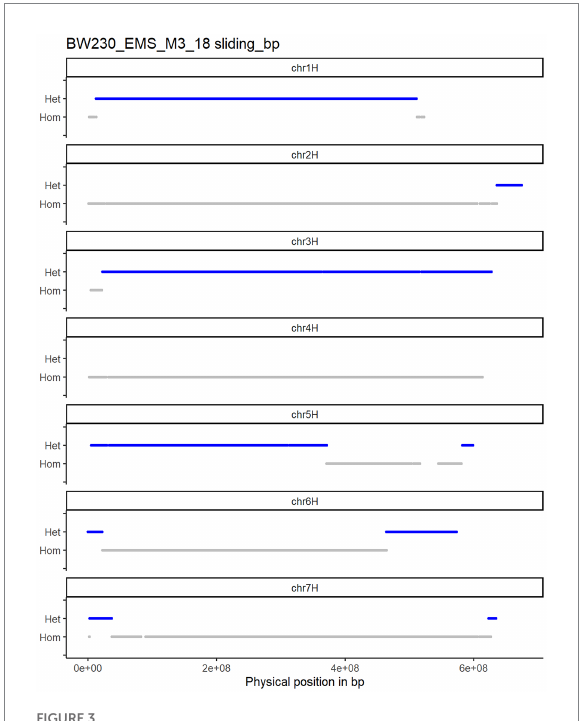
FIGURE 3 Plotted variant calling for Bowman_EMS_M3_18 plant after using the sliding window approach. COs can be counted at the positions where a switch from heterozygous (blue) to homozygous (grey) occurs.